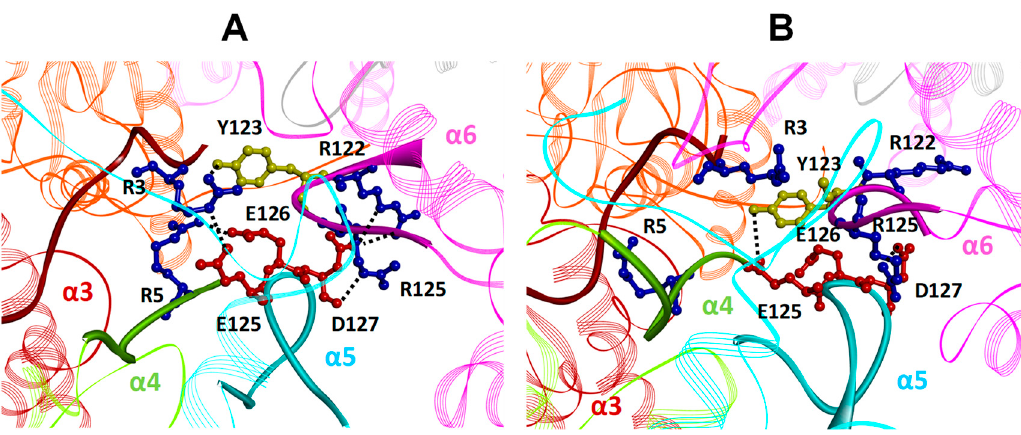
Figure 11. Close up view of the h20S α 5-loop interaction pattern in ( A ) h20S closed conformation (PDB ID: 4R3O) and ( B ) h20S docked with three Tris-T4 molecules (starting from the closed conformation). The α subunits are rendered in cartoons and colored in pink ( α 1), orange ( α 2), brown ( α 3), light green ( α 4), cyan ( α 5), magenta ( α 6), and gray ( α 7). The α 5-loop (cyan; aa120-135), the α 6-loop (magenta; aa120-128), the α 3 N-terminal tail (brown; aa1-15) and the α 4 N-terminal tail (light green; aa1-13) are evidenced as solid ribbons. Key residues are displayed in ball&stick and colored in red (E125, E126 and D127 ( α 5)), blue (R122 and R125 ( α 6)) and yellow (Y123 ( α 6)). This is accompanied by the formation of an H ‐ bond involving a Tyr residue on the α 6 ‐ loop of the α‐ annulus (Y123) and the α 3 N ‐ terminal tail (R3). Finally, the α 5 ‐ loop and the α 6 ‐ loop are coupled